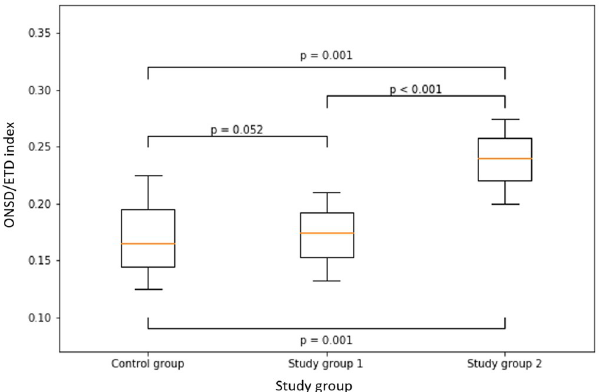
Fig 5. ONSD/ETD index according to clinical groups with corresponding p-values. ONSD/ETD index is significantly higher (p < 0.001) in patients with papilledema (median 0.24, IQR = 0.22–0.25) compared to patients in with no signs of papilledema (median 0.18, IQR = 0.16–0.19) and control group (median 0.17, IQR = 0.15–0.18). There is no significant difference between the control group and patients with no signs of papilledema (p = 0.052).